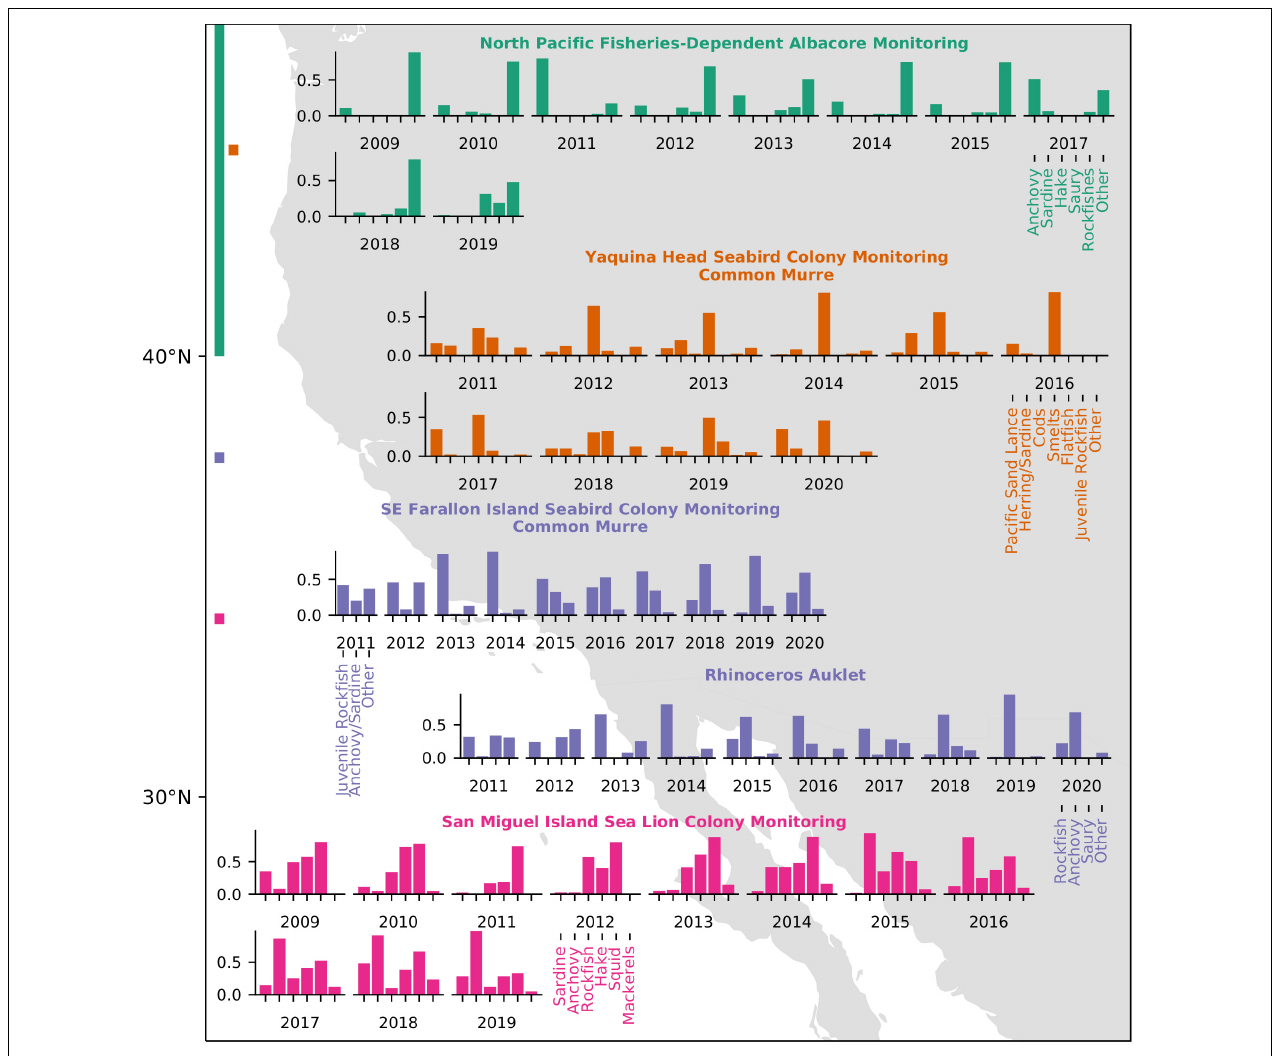
FIGURE 12 | Diet compositions of Albacore, seabirds, and sea lions in the CCS. Bars at left indicate the latitudinal sampling range of the surveys with colors corresponding to graphed